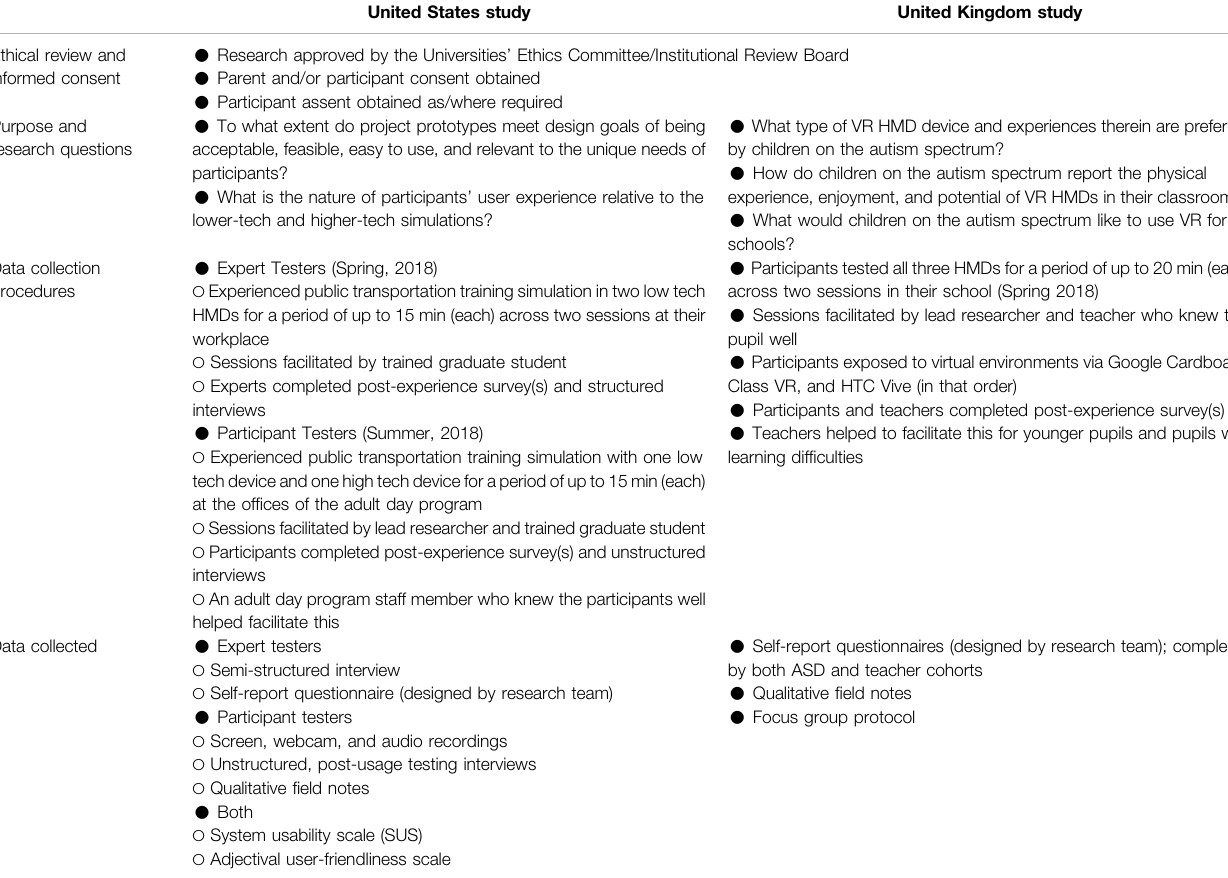
TABLE 2 | Outcomes of Phase 1: Results from analysis of studies (research aims, data collection protocols). United States study